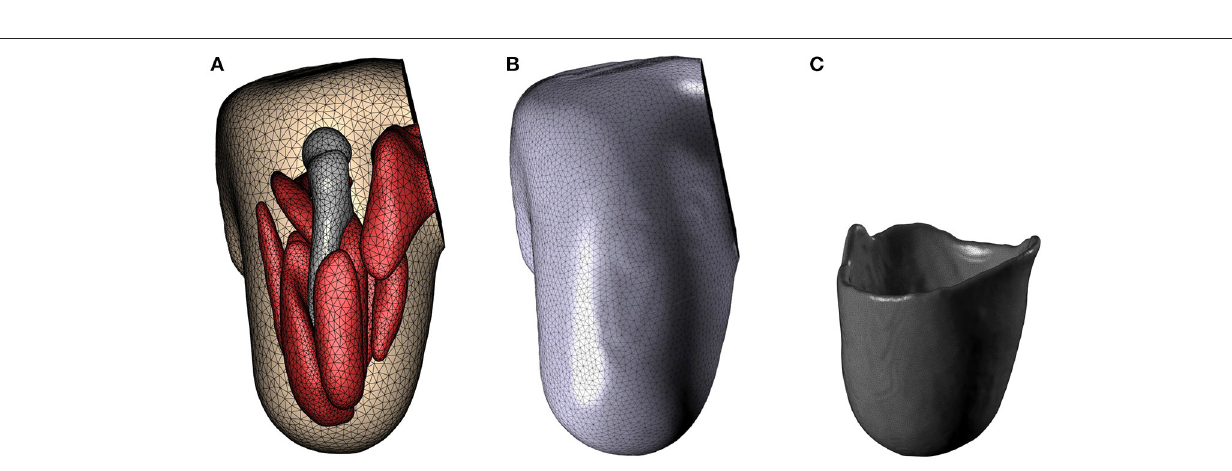
FIGURE 7 | FE mesh. FE meshes for the residual limb, liner and socket are presented in (A–C) ,